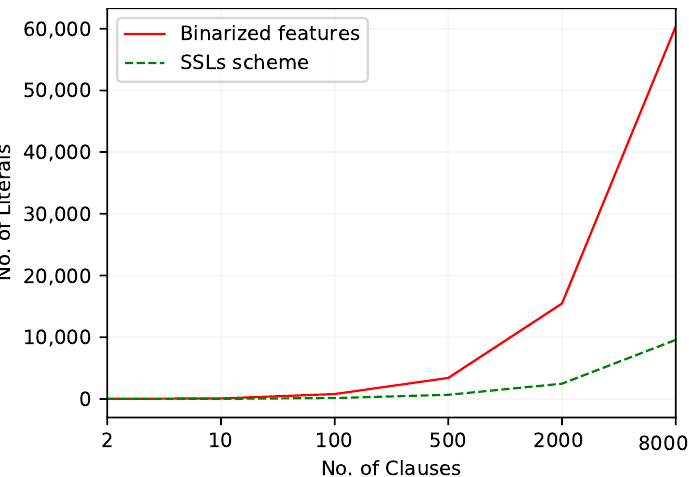
Figure 4. The number of literals included in TM clauses to work with the Balance Scale dataset.